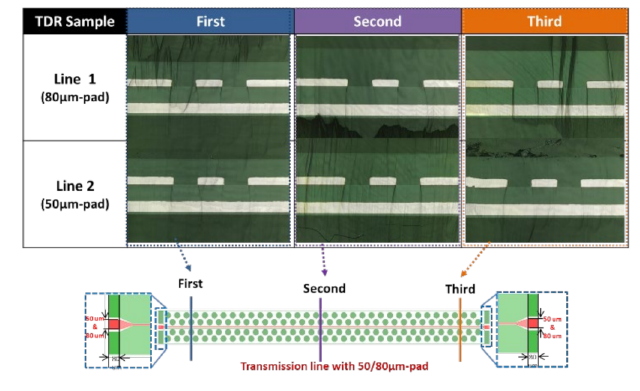
Figure 14. Cross-section